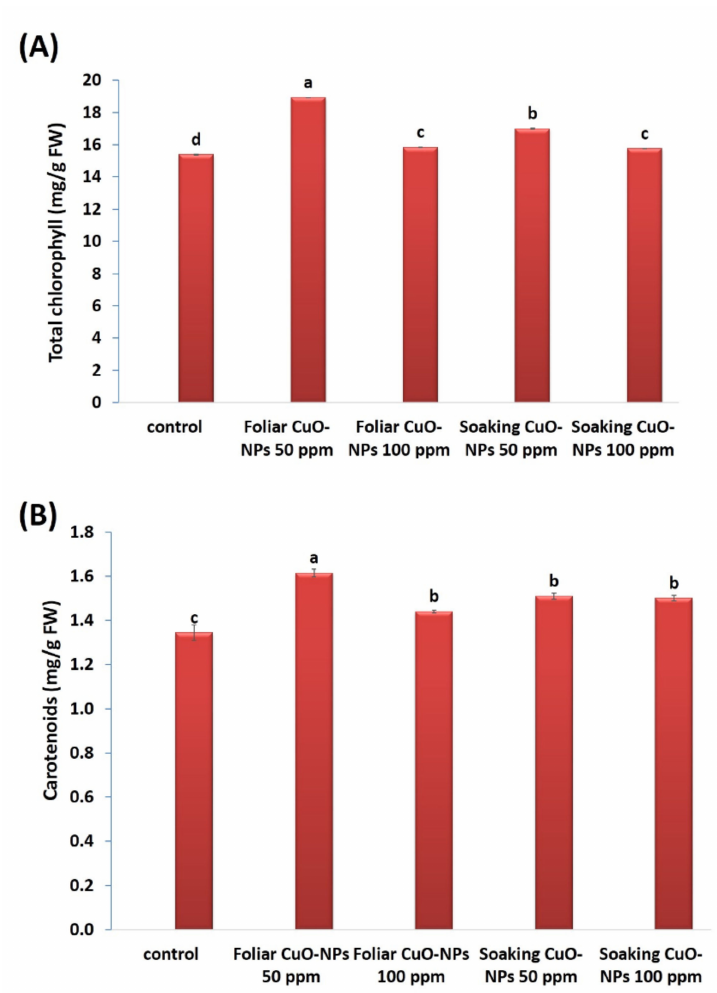
Figure 5. Assessing the effect of CuO-NPs on the total chlorophyll ( A ) and carotenoid ( B ) contents (mg/g FW) in wheat plants. Data are statistically different at p ≤ 0.05 by Tukey’s test, ( n = 3); different letters on bars indicate that mean values are significantly different at the significant level of ( p ≤ 0.05), error bars are means ± standard error